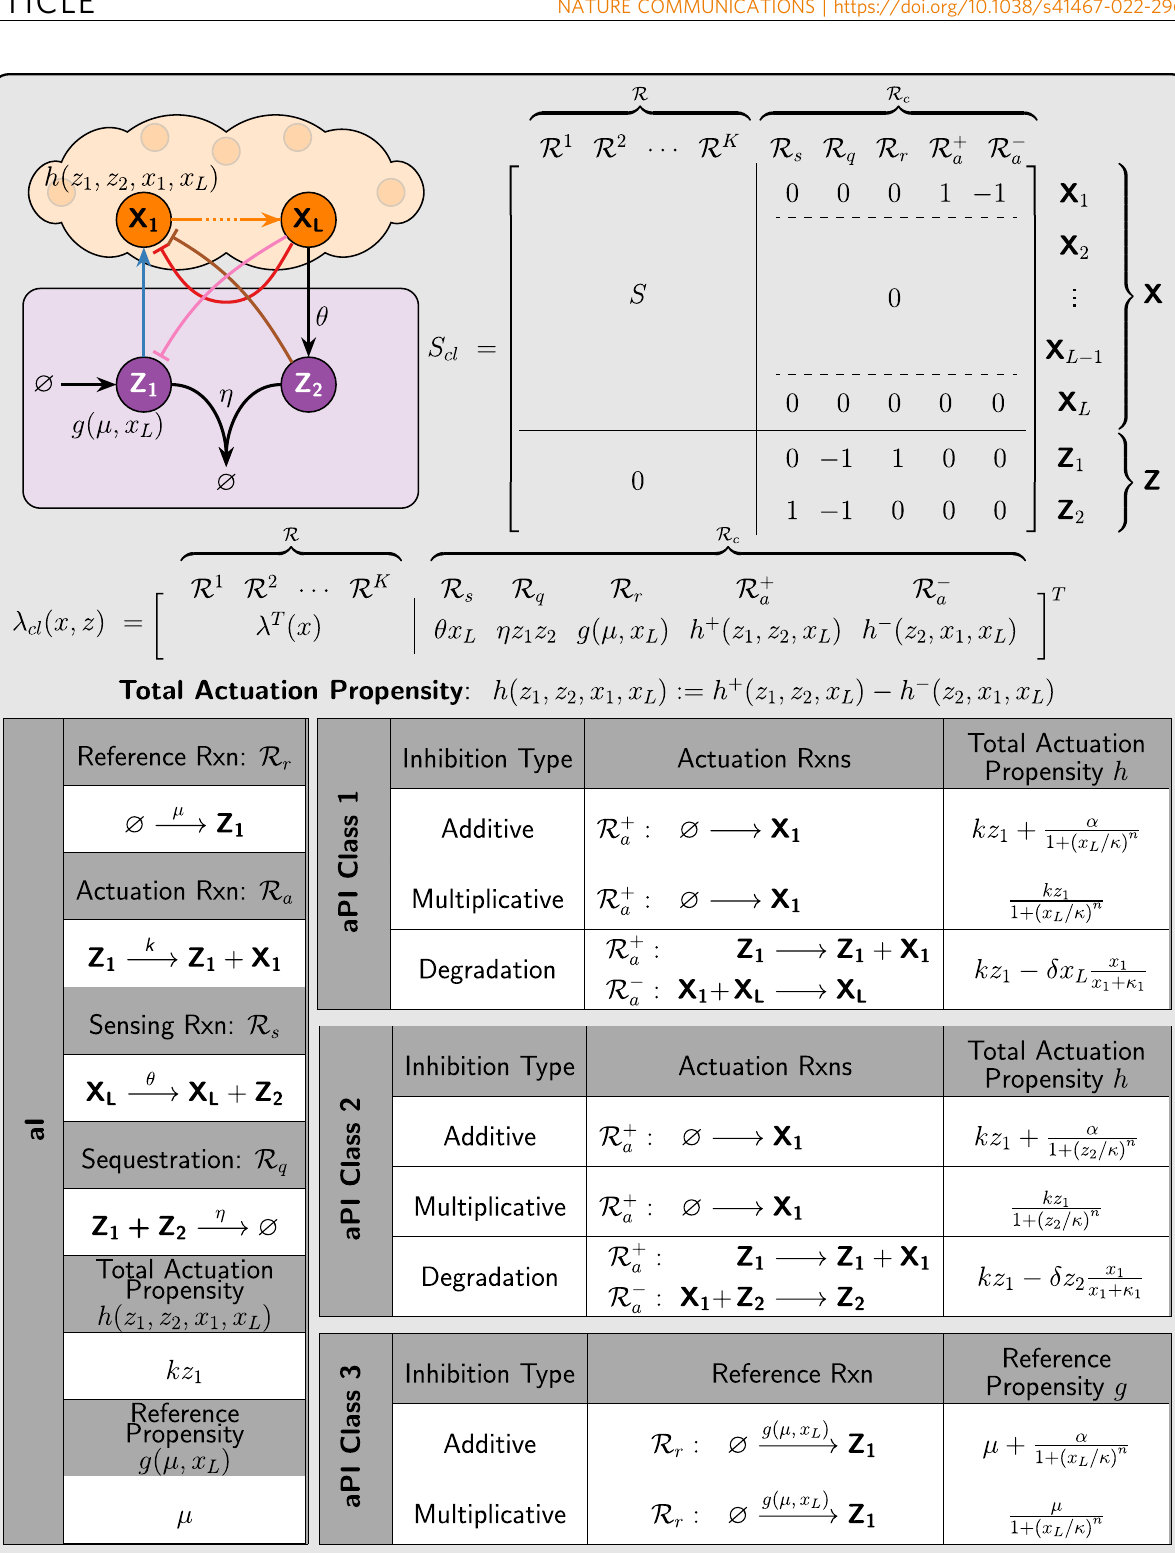
and degradation inhibitions outperform additive inhibition if stability is a critical objective. To this end, Fig. 4d shows how the settling time and overshoot can be tuned by the controller parameters α , κ , and δ for additive, multiplicative, and degradation inhibitions, respectively. It is shown that with multiplicative and degradation inhibitions, one can simulta- neously suppress oscillations (settling time) and